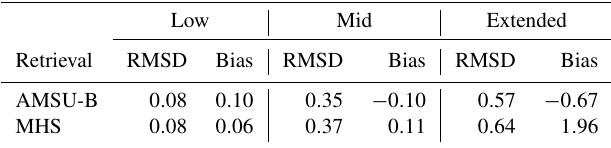
Table 4. Root mean square deviation (RMSD) and bias (kgm − 2 ) for MH08 retrievals from simulated signals for the low, mid and extended regimes (excluding overlap). The AMSU-B results are the same as in Case 1 from Table 3.